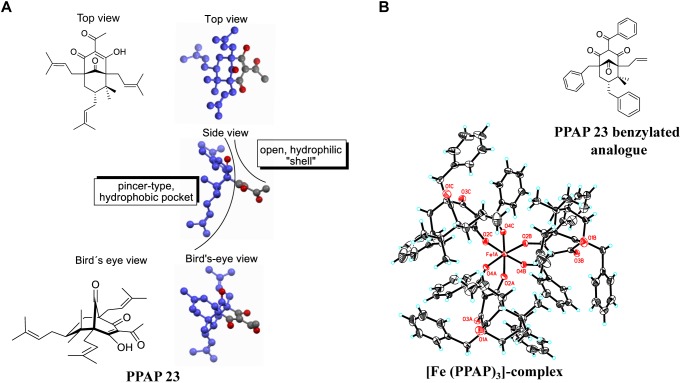
(A) 3D-structure of PPAP 23 showing the hydrophobic pocket (dark blue) and the hydrophilic shell; the gray atoms belong to the hydrophilic substructure, and the oxygen atoms of the four carbonyl functionalities are highlighted in red. (B) crystal structure of an Fe- PPAP complex showing a highly defined octahedral coordination of the 1,3-diketone motif to an Fe(III)-center. The iron in the middle (Fe1A) and the oxygen atoms are highlighted in red.